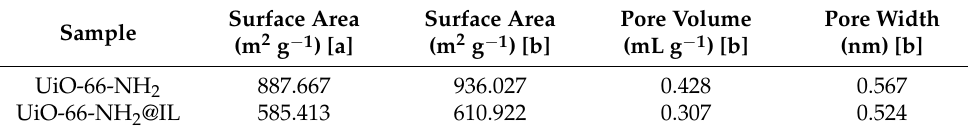
Figure 2. ( a ) SEM image of UiO-66-NH 2 @IL particles; ( b ) XRD patterns of UiO-66-NH 2 and UiO-66-NH 2 @IL particles; ( c ) FT-IR spectra of [bmim][Tf 2 N], UiO-66-NH 2 and UiO-66-NH 2 @IL; ( d ) N 2 adsorption/desorption isotherm of UiO-66-NH 2 and UiO-66-NH 2 @IL. Table 1. Gas Sorption Data of UiO-66-NH 2 and UiO-66-NH 2 @IL.